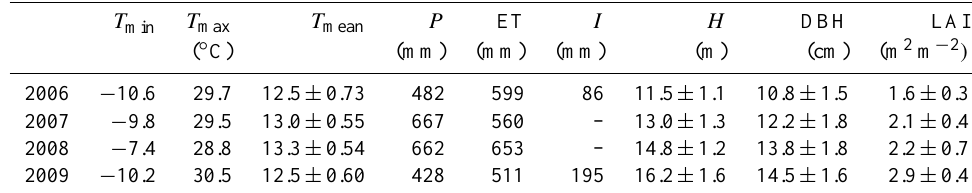
Table 1. The stand characteristics of 4 years from 2006 to 2009, including the minimum, maximum, and mean temperature ( T ), the annual precipitation ( P ), evapotranspiration (ET), irrigation ( I) , canopy height ( H) , breast height diameter (DBH), and leaf area index (LAI). The error estimates are standard deviation